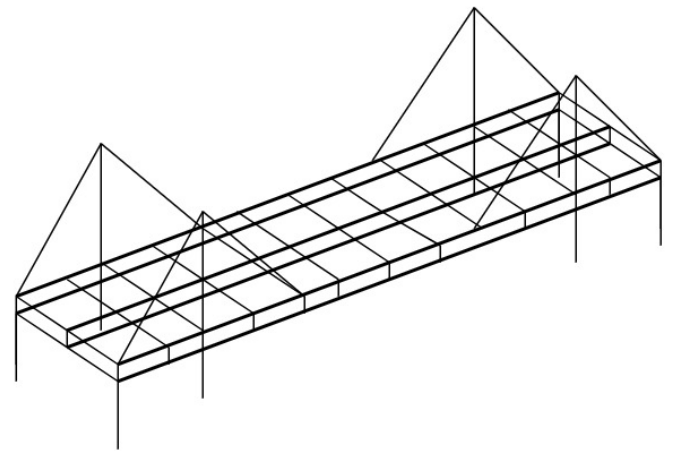
Figure 4. Triple-girder model.